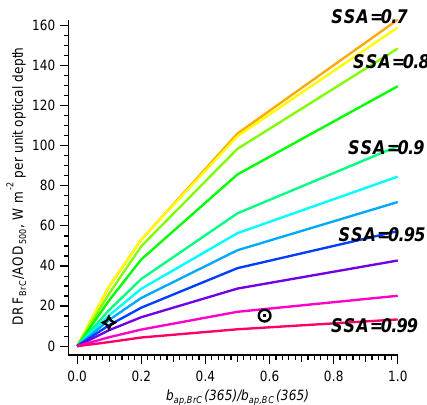
Figure 10. BrC radiative forcing efficiencies, defined as the BrC TOA direct radiative forcing divided by AOD at 500nm, as a func- tion of BrC to BC absorption ratio and SSA measured at surface at 365nm. The circle corresponds to average background condi- tions determined from the DC3 campaign. The star represents a surface measurement from southeast USA, where altitude-resolved data were not